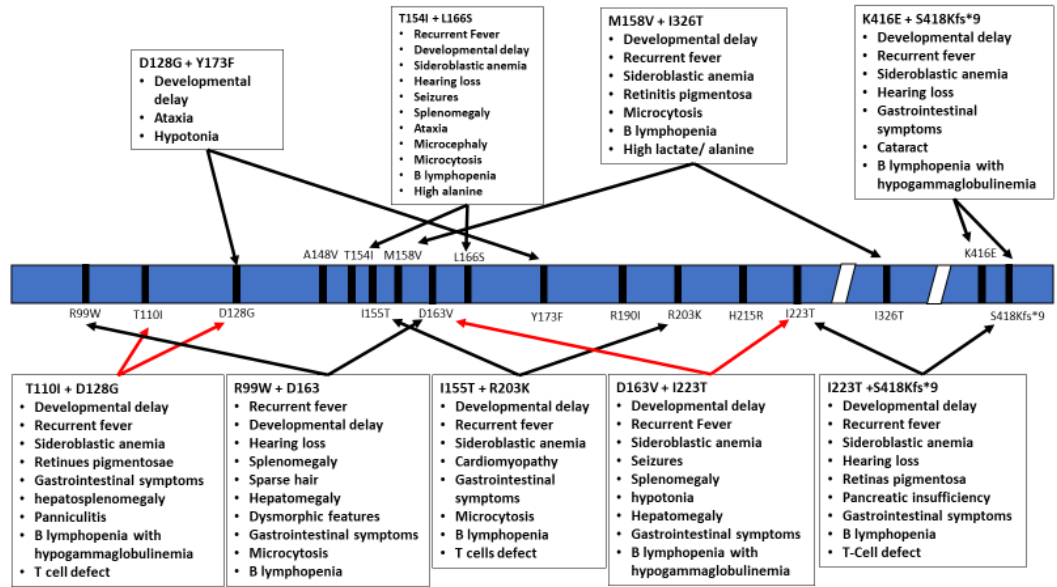
Figure 3. Schematic representation of the TRNT1 protein with indicated positions of heterozygous mutations in TRNT1. The specific phenotypes associated with these mutations are listed in boxes above and below the protein. Red arrows indicate severe symptoms, while black arrows indicate mild phenotype.